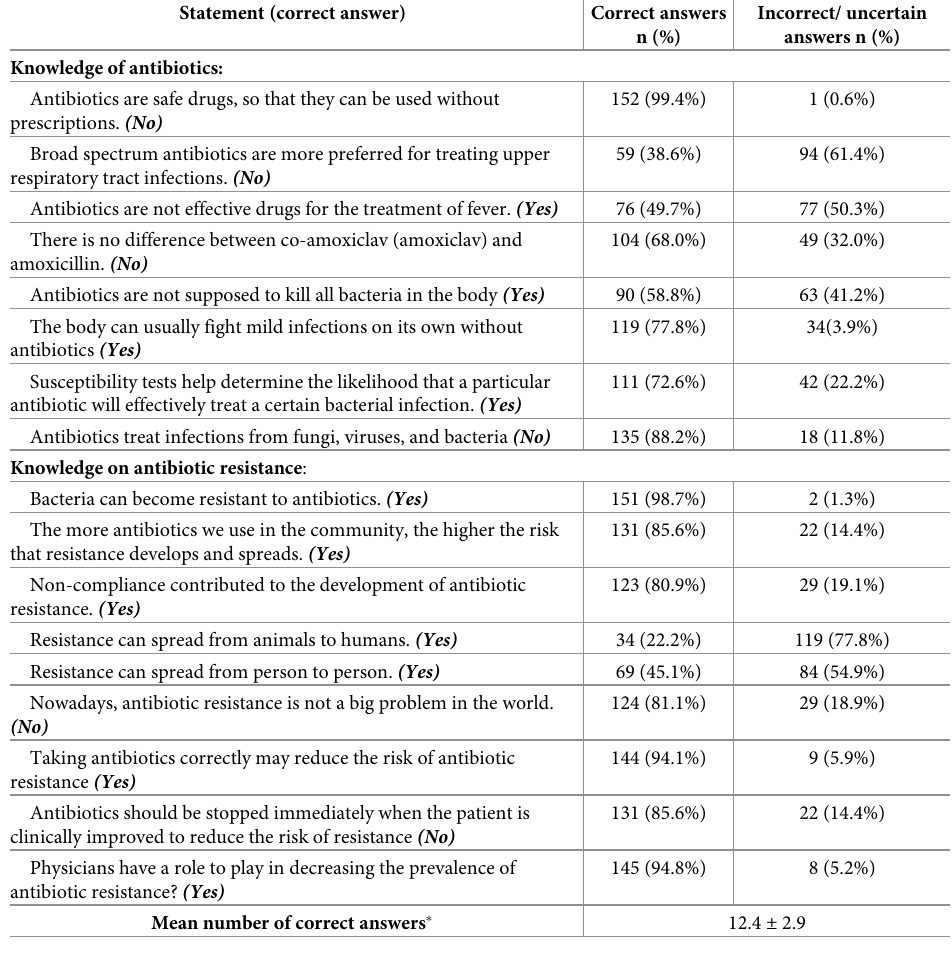
Table 3. Knowledge about antibiotic use and antibiotic resistance among participants. Statement (correct